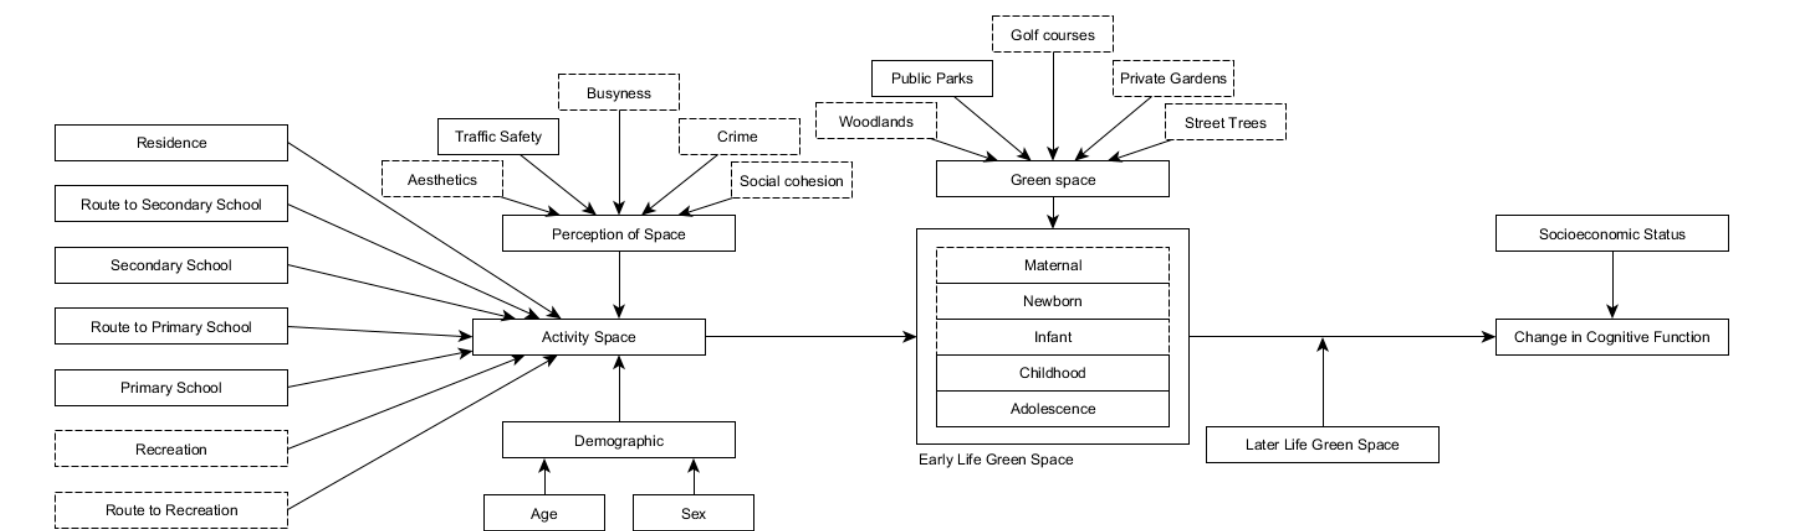
Figure 1. The conceptual model of the relationship between early life green space and cognitive aging in later life. The continuous lined boxes: Measured in the current study. The dotted lined boxes: Unmeasured in the current study.